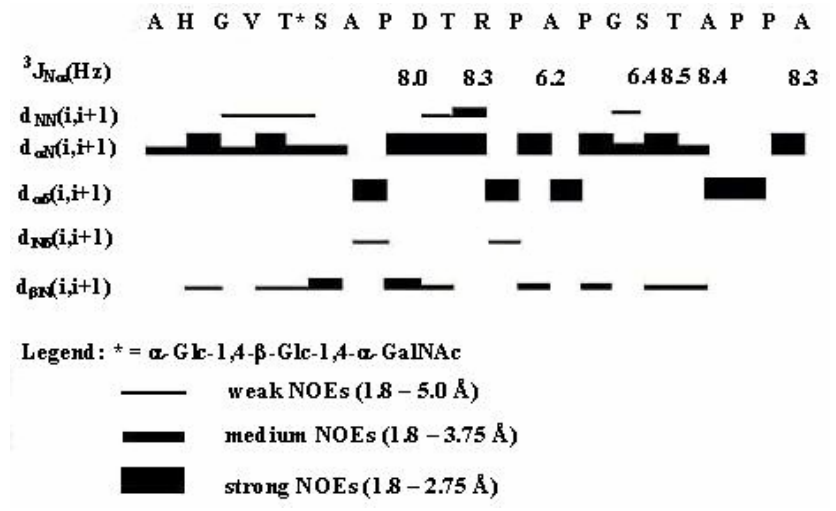
Figure 1. Summary of sequential NOE connectivities and coupling constants observed between amino acid residues in the peptide backbone.